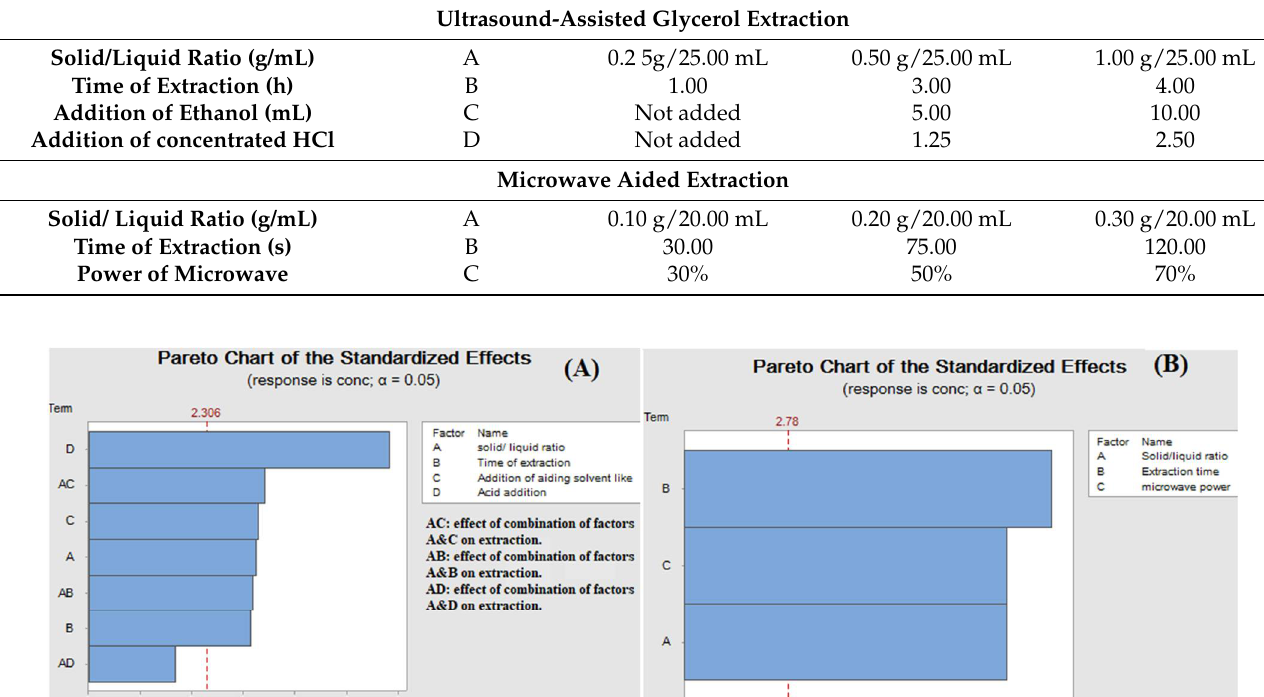
Table 2. Summary of the factorial design for factors that affected the extraction of red onion scales by ultrasound-assisted glycerol extraction protocol and microwave-assisted extraction.